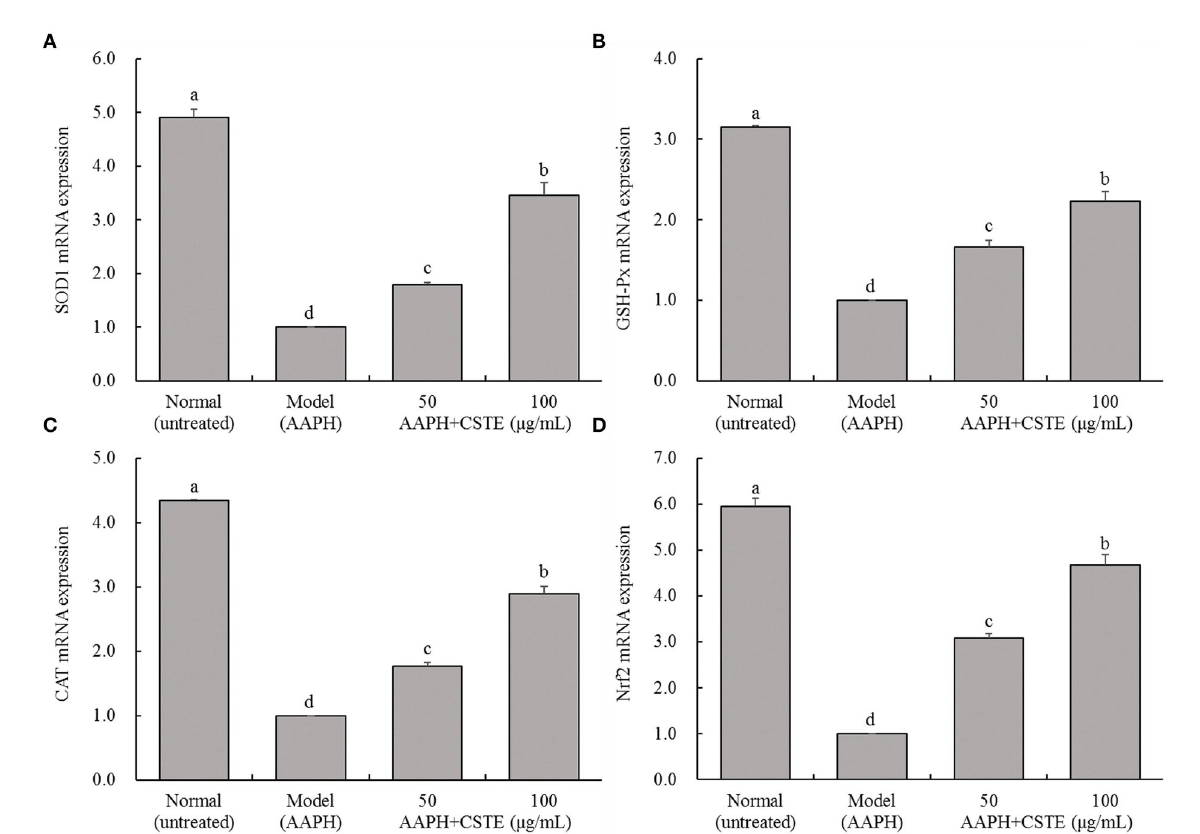
FIGURE7 SOD1, GSH-Px, CAT and Nrf2 mRNA expression of AAPH inducing oxidative damaged HL-1 cardiomyocytes, (A) SOD expression, (B) GSH-Px expression, (C) CAT expression, (D) Nrf2 expression; CSTE: Clerodendranthus spicatus (Thunb.) C. Y. Wu extract. a − d according to Duncan’s multi range test, the average values of different letters in the same column have significant differences ( P < 0.05, n = 6).